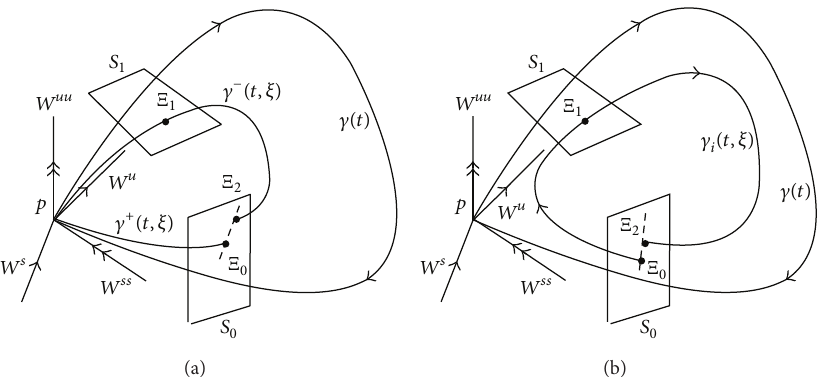
Figure 1: The gap ‖𝛾 − (𝑇,𝜉)−𝛾 + (𝑇,𝜉)‖ ̸= 0 in (a); there is no homoclinic orbit in general. The gap ‖𝛾 𝑖 (𝑇+𝑇 𝑖 +𝜏 𝑖 ,𝜉)−𝛾 𝑖 (𝑇,𝜉)‖ ̸= 0 in (b); there is no periodic orbit in